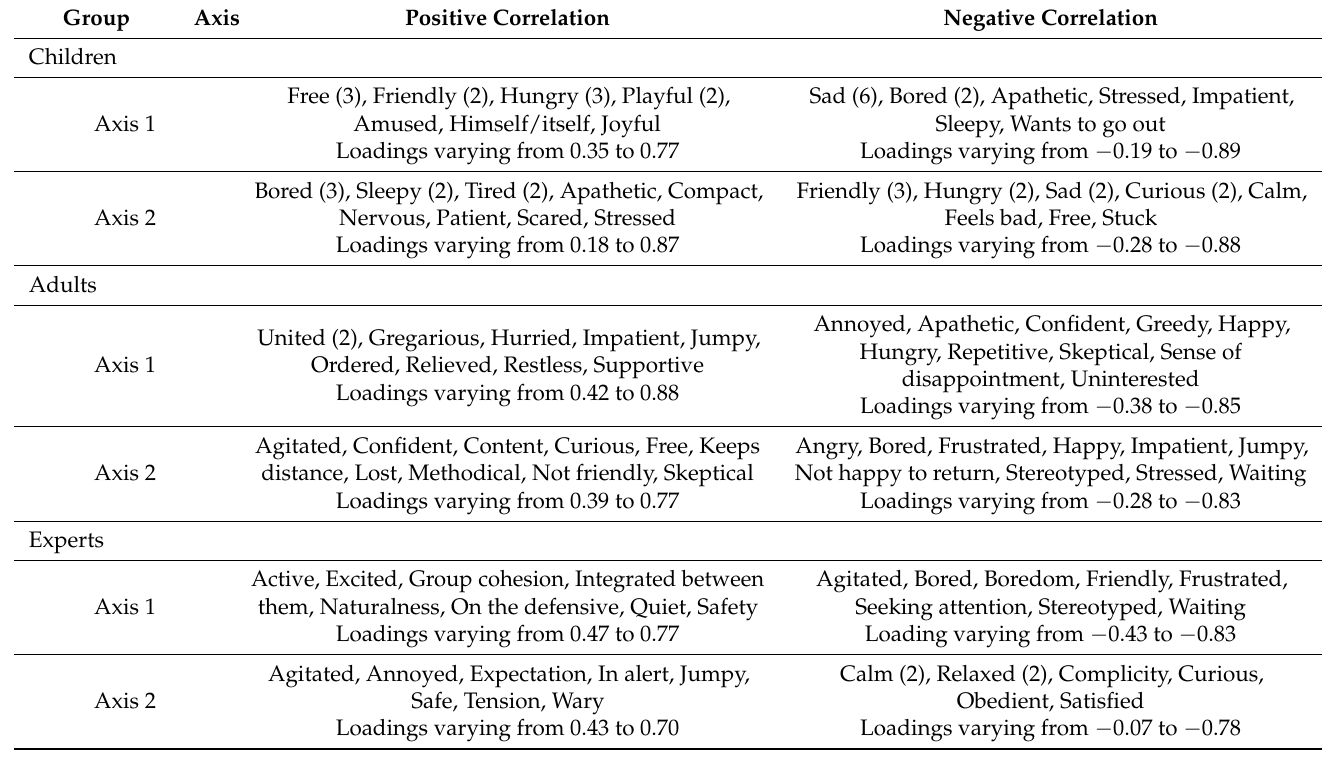
Figure 2 indicates the strength of correlation (r-values) for all descriptors of dimen- sion 1 and dimension 2. All the descriptors used by the three observer groups show a weak level of correlation on both